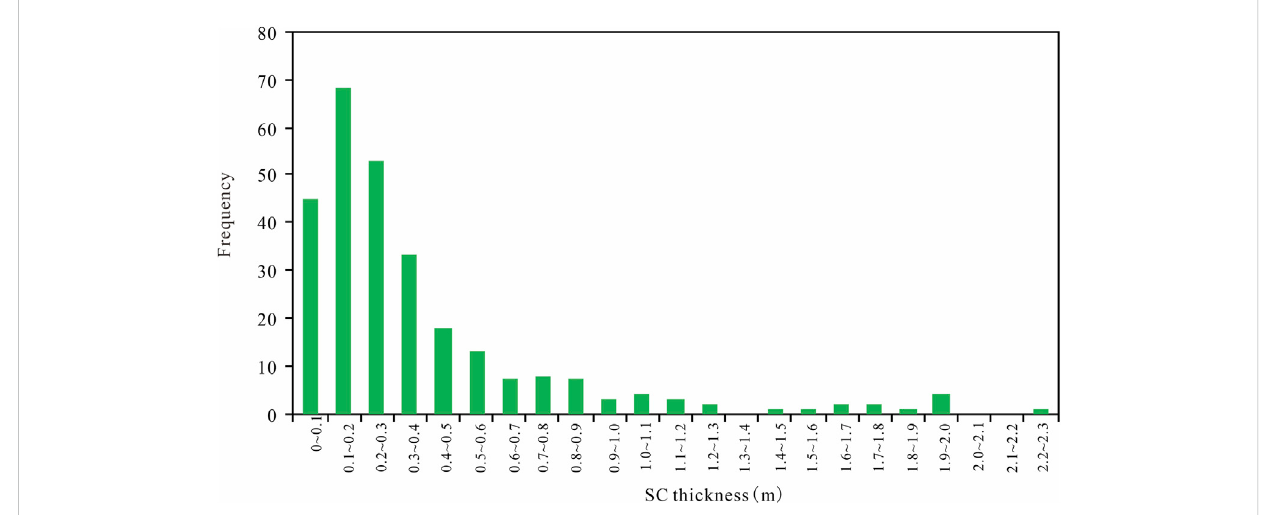
FIGURE 5 Frequency histogram of SC thickness in Es 4 u of Well